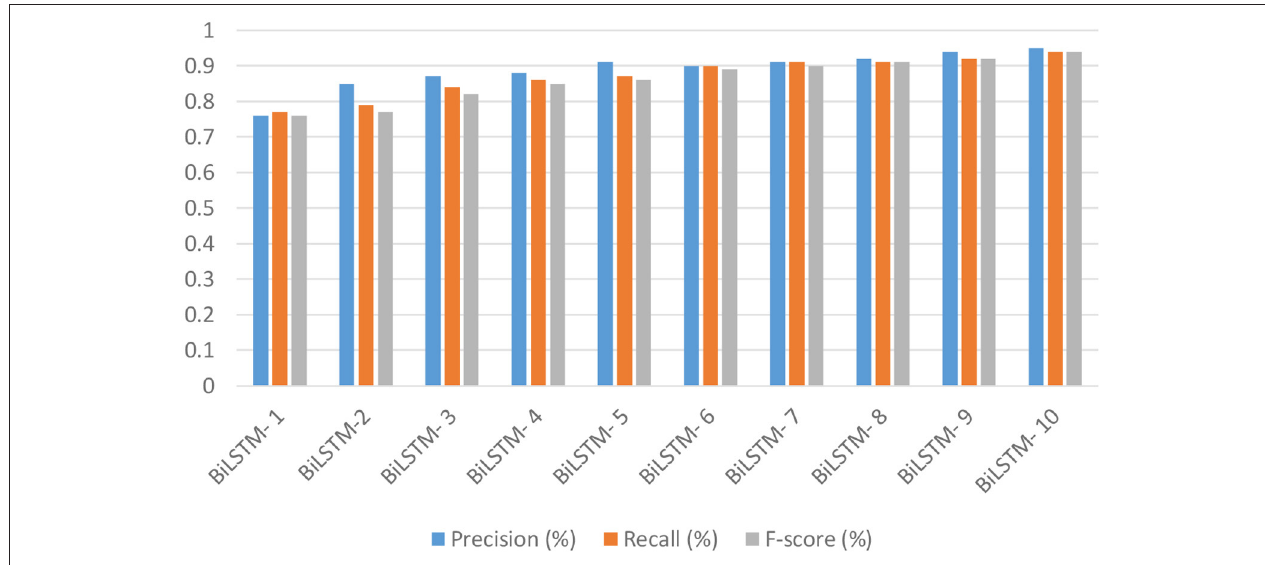
FIGURE 13 | The accuracy, recall, and f1-score of the BiLSTM deep learning models.